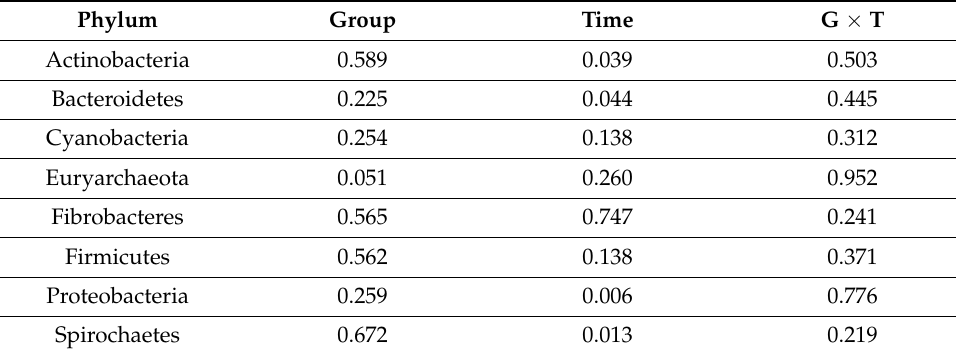
Table 5. p -values associated with the statistical analysis of the relative abundances of the bacterial and archaeal communities in the ruminal samples with a linear mixed model.